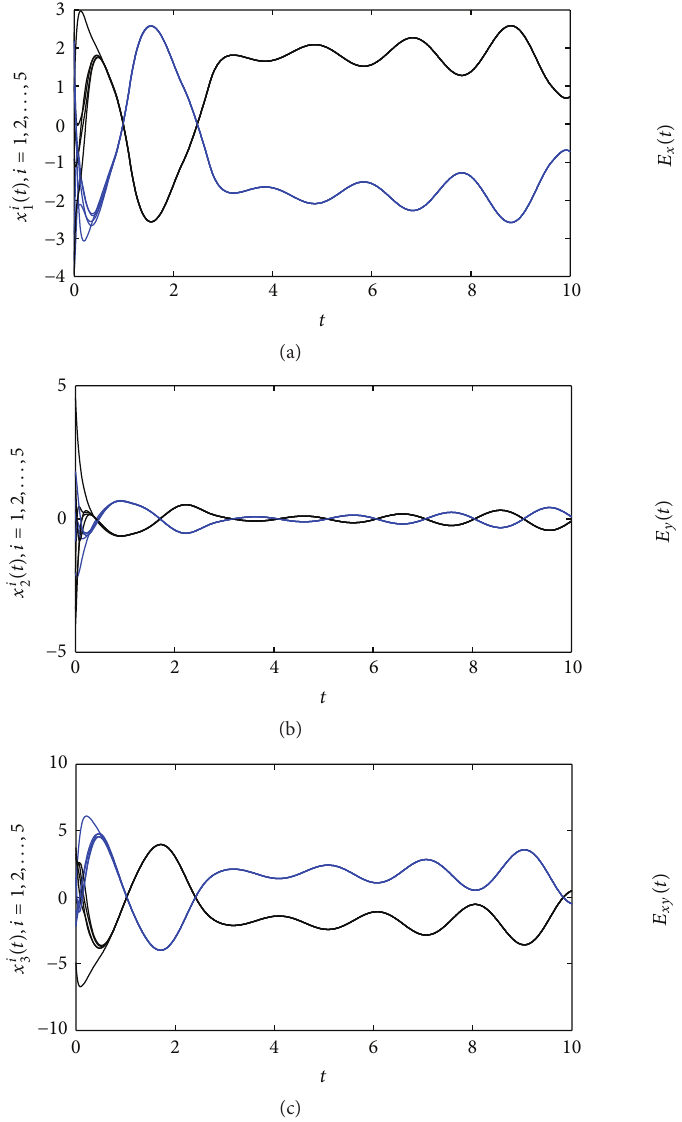
Figure 4: (a) The synchronization error evolution of the driver networks 𝐸 𝑥 (𝑡) . (b) The synchronization error evolution of the response networks 𝐸 𝑦 (𝑡) . (c) The antisynchronization error evolu- tion between the driver networks and the response networks 𝐸 𝑥𝑦 (𝑡) with the pinning